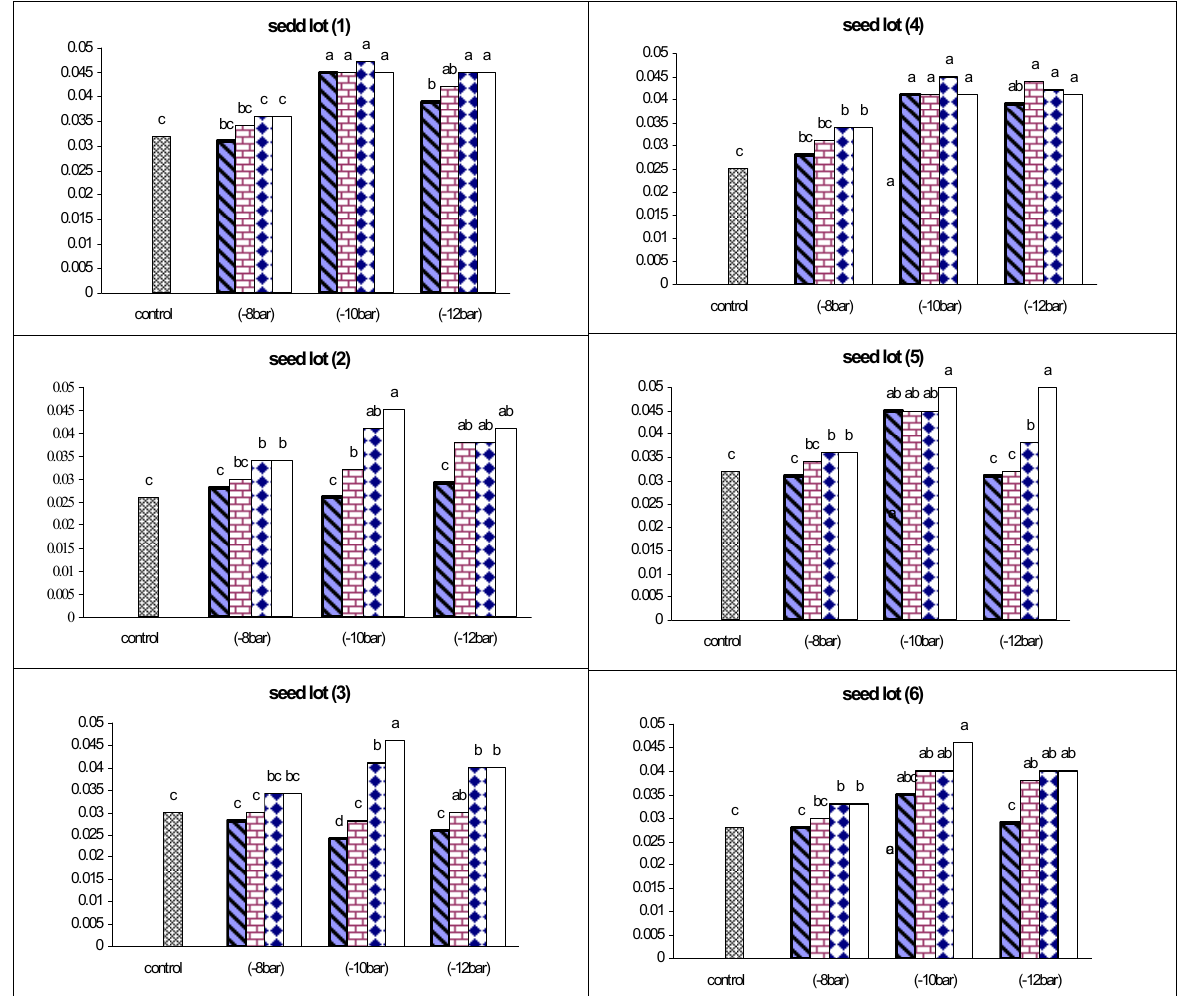
Fig. 2. Influence of osmotic potential levels of osmopriming treatments on the germination rate (GR) in soybean seed lots (cv. ‘Sari’) under 12 , 24 , 36 and 48 hours durations. Horizontal axe shows priming with -8 bar; -10 bar; - 12 bar; polyethylene glycol and 0 bar as a control group . Vertical axe is germination